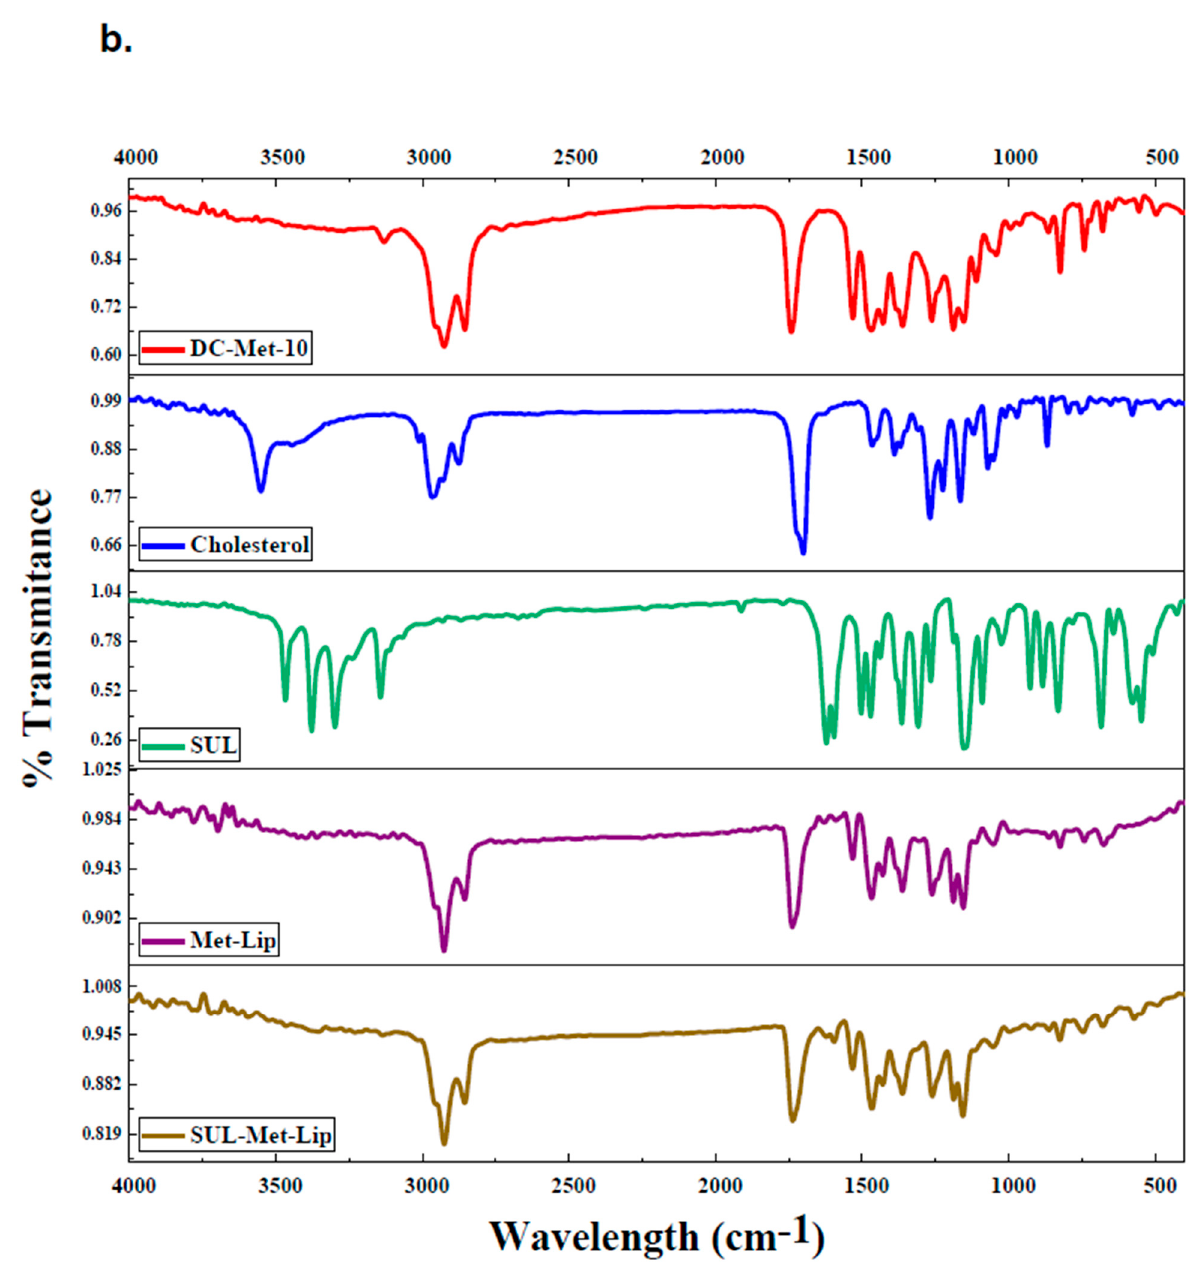
Figure 4. FT-IR spectra of drug-loaded nanocarriers. ( a ) FTIR of synthesized amphiphilic molecule (DC-Met-10), cholesterol, pure Moxifloxacin (MOX), without drug and drug-loaded vesicles (Met-Lip and MOX-Met-Lip), respectively. ( b ) FTIR of synthesized amphiphilic molecule (DC-Met-10), cholesterol, pure Sulfamethoxazole (SUL), without drug and drug-loaded vesicles (Met-Lip and SUL-Met-Lip), respectively.